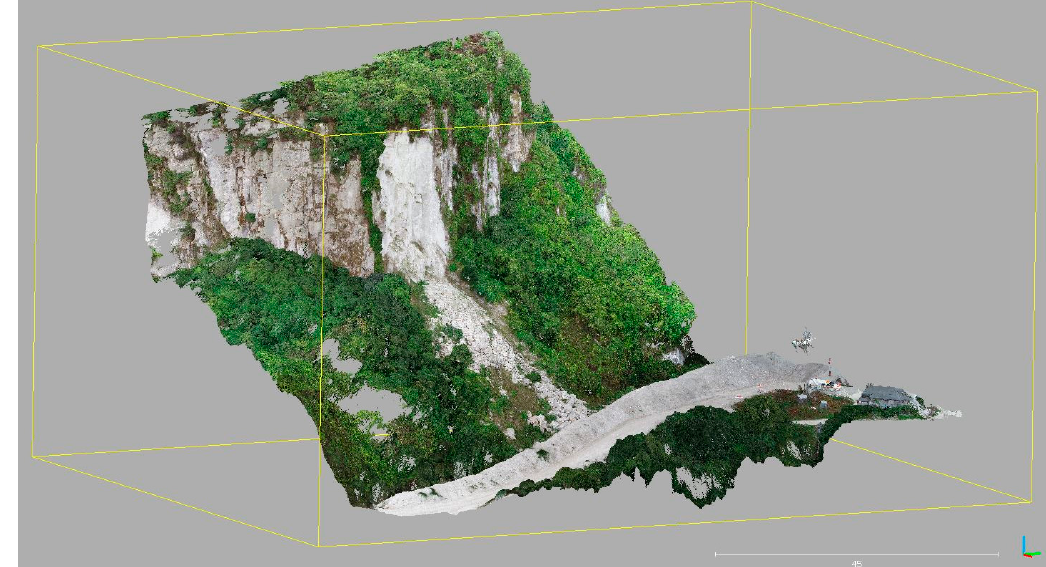
Figure 4. Coloured Structure from Motion Multi-View Stereo (SfM-MVS) point cloud image, acquired using a Phantom 4 DJI platform equipped with a 20 MP RGB camera and processed in Agisoft Photoscan™. The Unmanned Aerial Vehicle (UAV)-hosted sensor enabled the complete reconstruction of shadowed regions in the scene in the TLS survey.